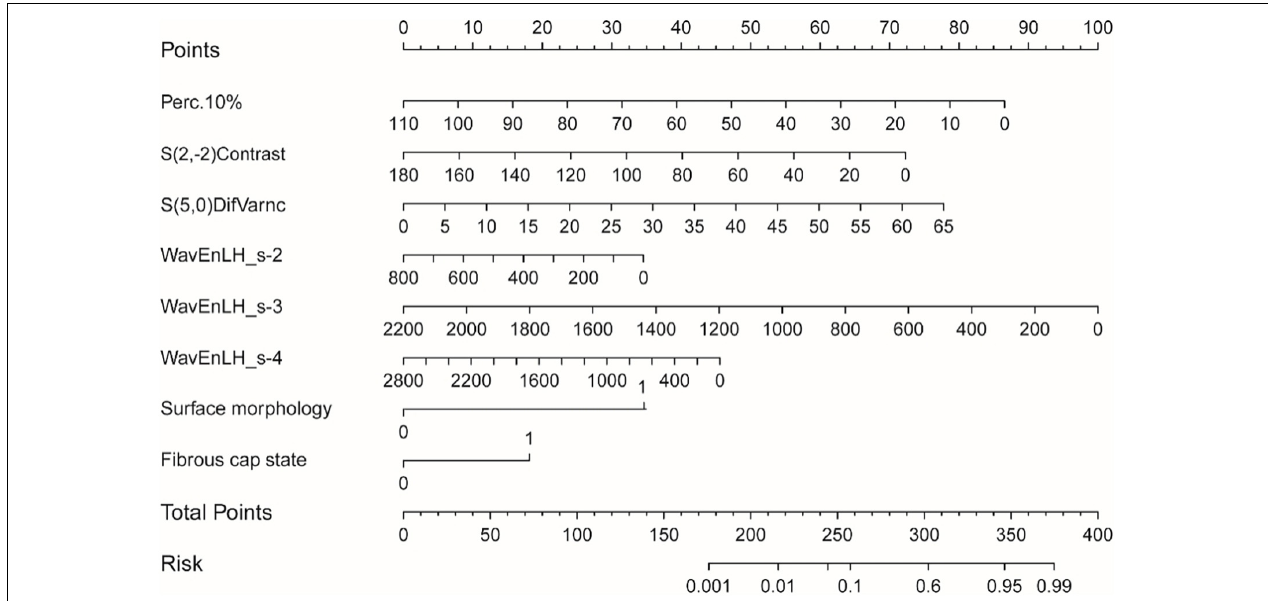
FIGURE 5 | The nomogram was constructed based on the combined model, and the scores of each variable were added to obtain the total score, corresponding to the risk probability of predicting a vulnerable plaque. The nature of each plaque in the nomogram can be directly read out.